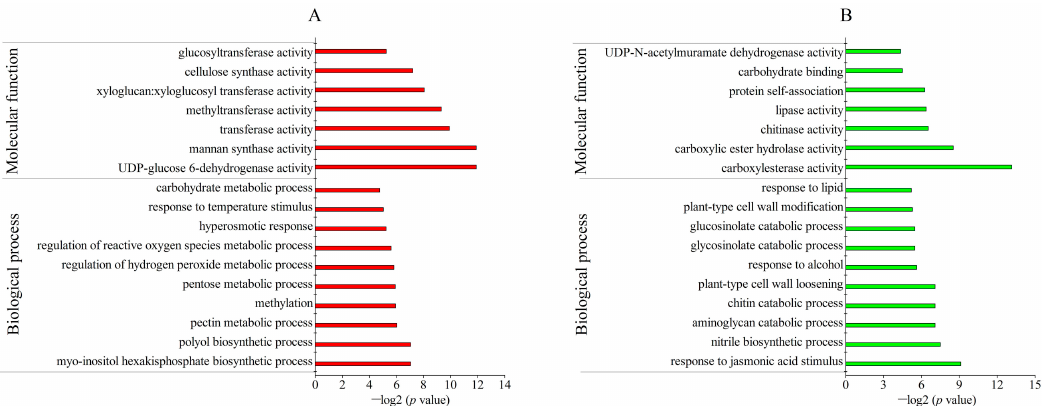
Figure 5. GO enrichment analysis of up- and down-accumulated DAPs between 4RTR and 4RCK. ( A ) Up-accumulated proteins; ( B ) down-accumulated proteins.